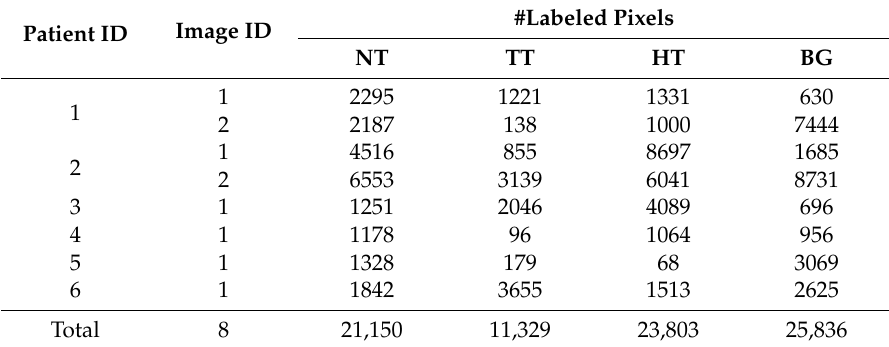
Table 3. Summary of the test dataset employed for the algorithm